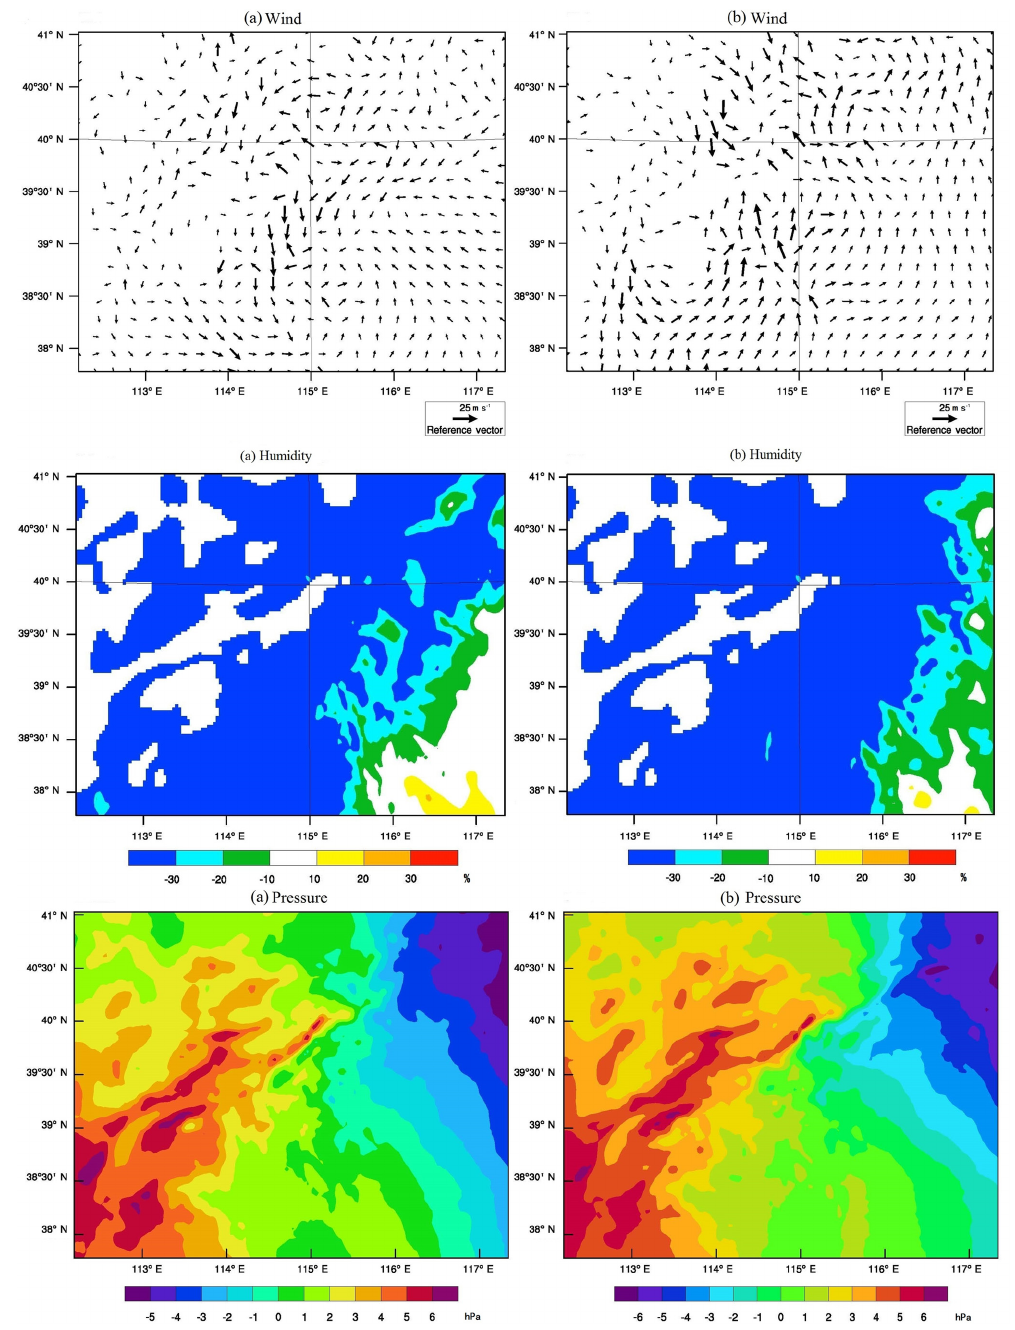
Figure 8. The increment distributions of wind, humidity and pressure in Domain 2 at 850hPa for (a) assimilating only radar reflectivity and (b) assimilating both radar reflectivity and GTS